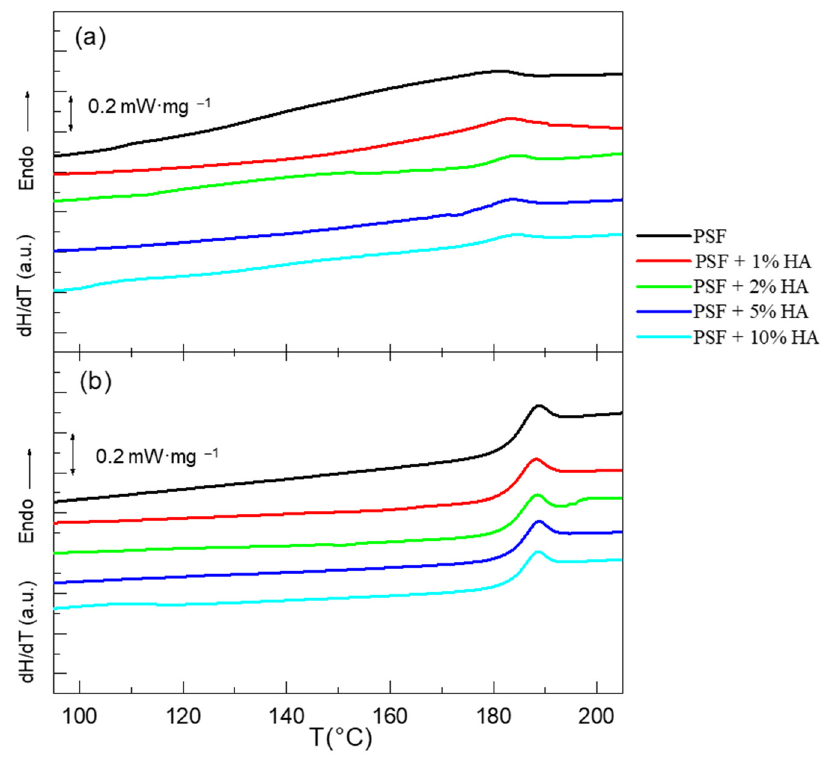
Figure 8. DSC traces corresponding to the ( a ) first and ( b ) second heating scan of PSF, PSF + 1%HA, PSF + 2%HA, PSF + 5%HA, and PSF + 10%HA. Table 2. Transition temperatures, T g , and changes in the heat capacity, C p , determined from the DSC thermograms of the samples under study for the first and second heating